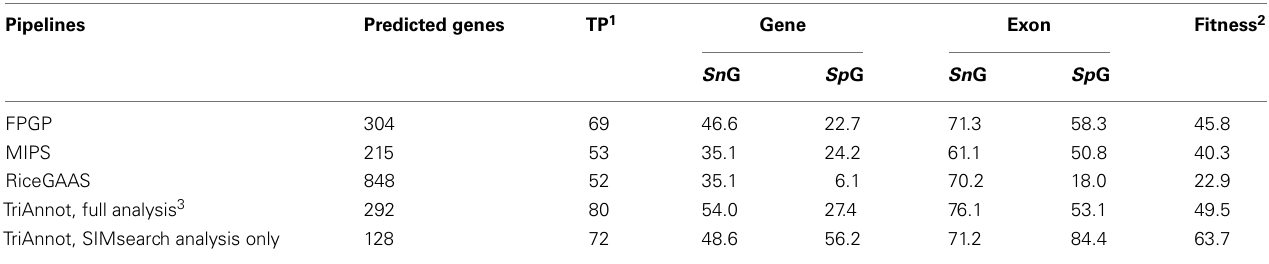
Table 1 | Comparisons of the fitness ofTriAnnot with other well known annotation pipelines based on a reference dataset containing 145 genes (17.9Mb of wheat chromosome